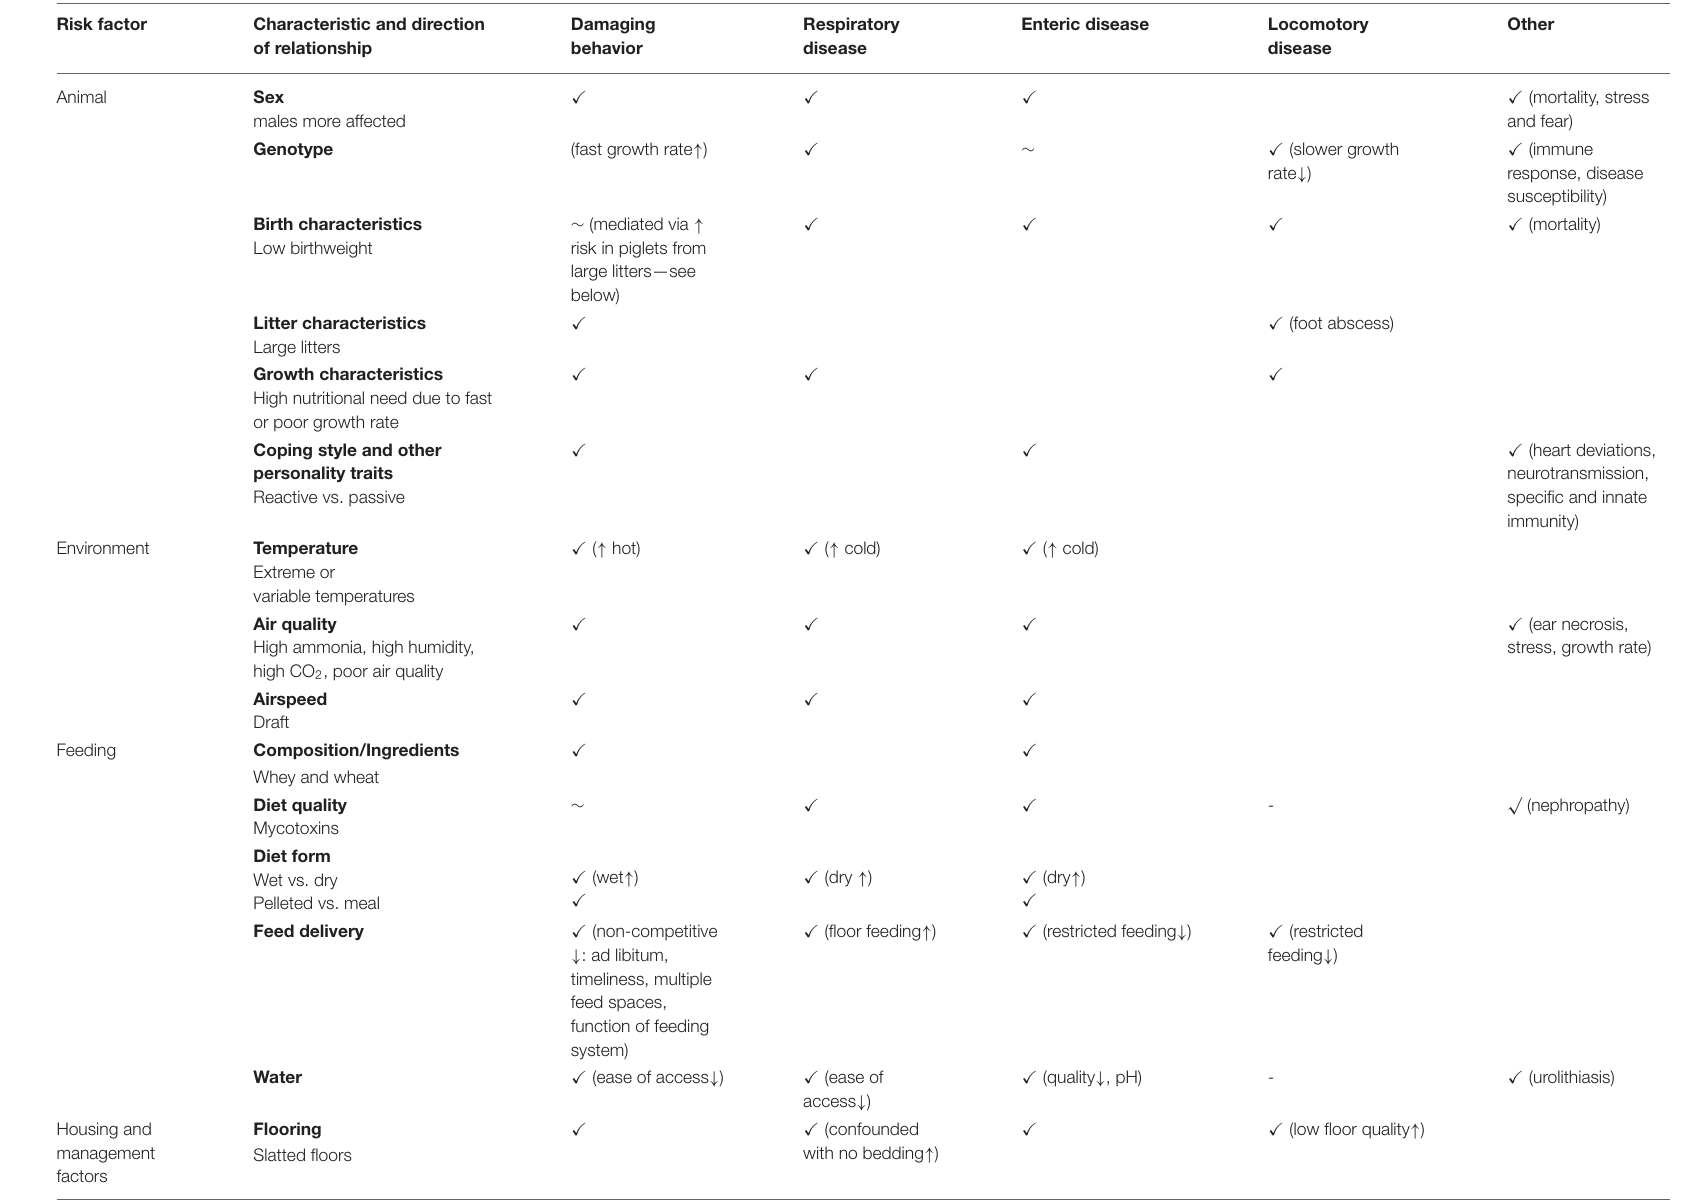
TABLE 2 | Studies supporting animal, environment, feeding, housing and management related risk factors shared between health conditions and damaging behavior and the direction of the relationship for specific characteristics. Risk